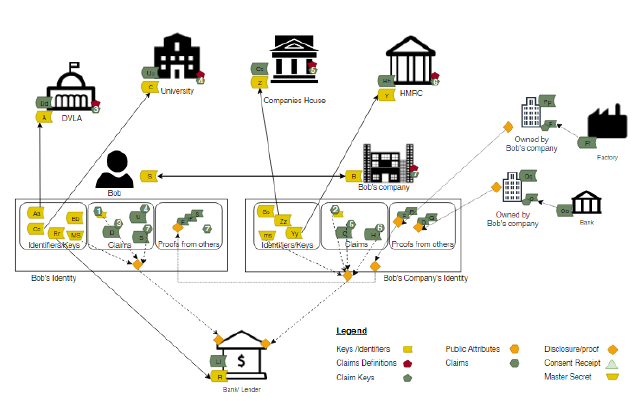
Figure 2. Different aspects of identity on the blockchain. Entities have identifiers, claims about identity attributes and proofs from others regarding their relationships. Relationships with other entities are recorded on the blockchain and entities collect verifiable claims about their identity. Solid lines represent relationships, whereas dotted lines represent a verifiable claim disclosure and the dashed line represents a delegated claim from a third party. The longer they are on the blockchain, the more verifiable claims they will collect from the relations they have on the blockchain. Entities can disclose verifiable claims to a third party, on need basis. Entities can mix and match certain aspects of their identities without revealing more than what is required. This helps in